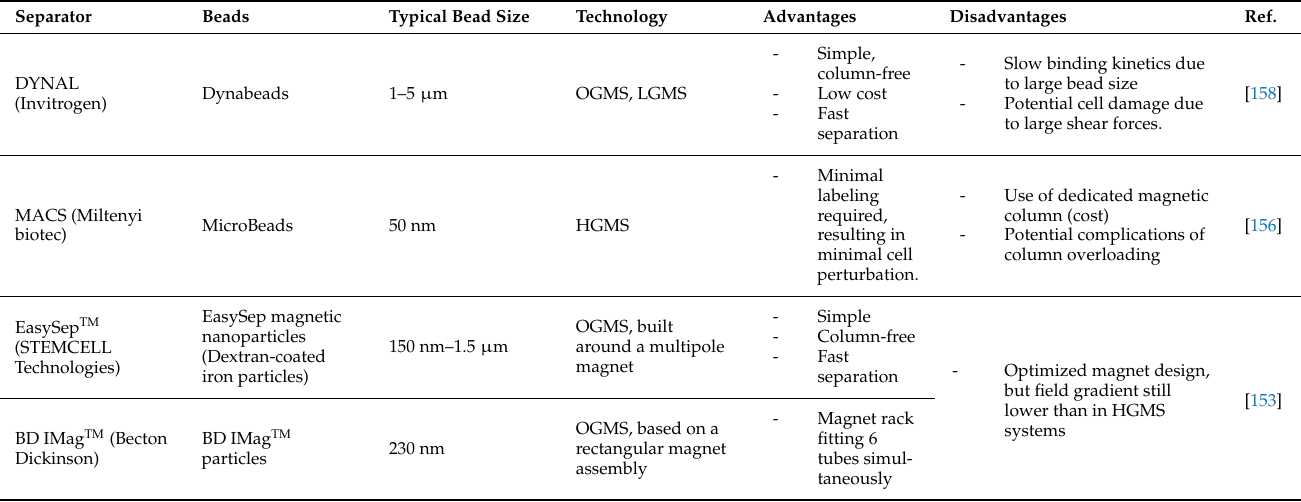
Table 2. Characteristics of some commercial cell separation technologies and their respective advan- tages and